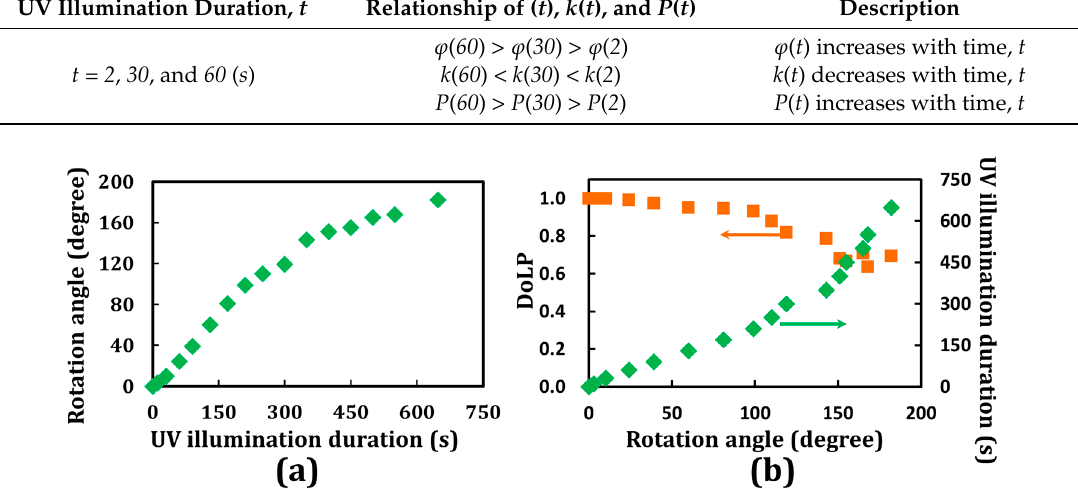
Figure 4. ( a ) Experimental results of the rotation angle as a function of the UV illumination duration; ( b ) experimental results of the DoLP as a function of rotation angle.